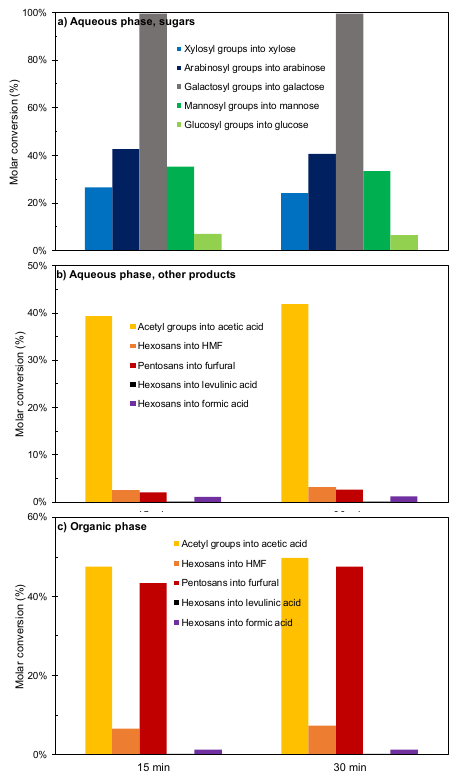
Figure 2. Results achieved in experiments performed at 180 °C using [C4mim]HSO 4 as a catalyst. ( a ) Sugars in aqueous phase. ( b ) Other compounds in aqueous phase. ( c ) Compounds in organic phase.